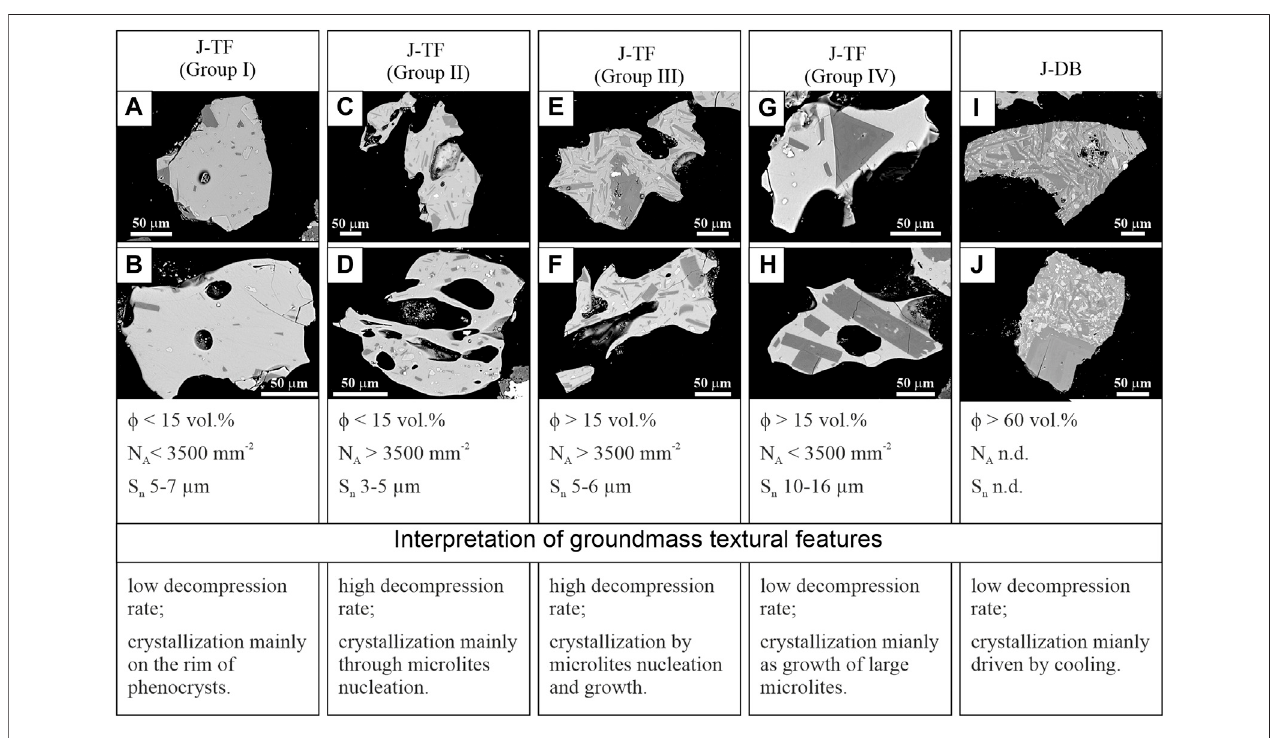
FIGURE 7 | Representative high-resolution BSE-SEM images for in-depth inspection of the groundmass texture. (A – H) Juvenile transparent and fl uidal (J-TF) particles belonging to (A,B) Group I, (C,D) Group II, and (E,F) Group III. (G,H) Group IV; (I,J) Juvenile dark and blocky particle (J-DB).